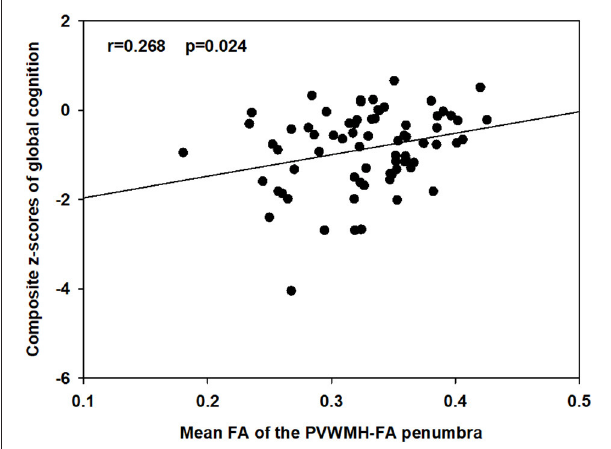
FIGURE 3 | Associations between the mean FA of the PVWMH-FA penumbra and the composite z-scores of global cognition. Partial r and p -values was obtained after controlling for age, sex, and